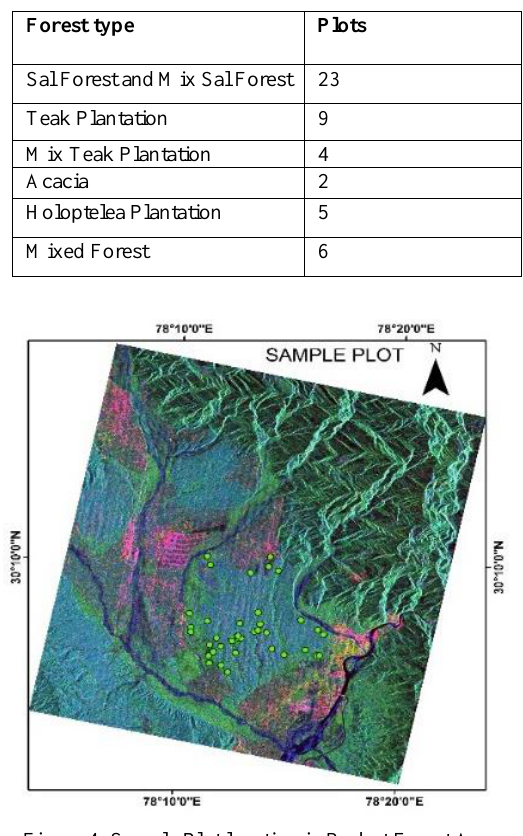
Figure 4: Sample Plot location in Barkot Forest